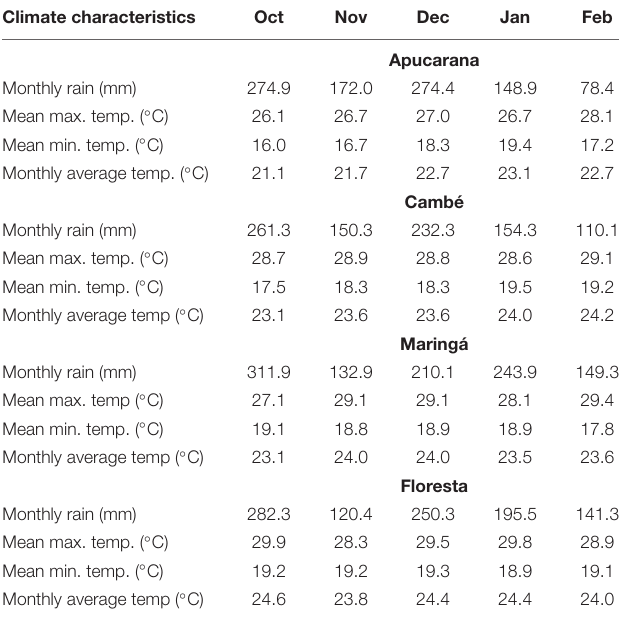
Table 1 ) and general guidelines for crop